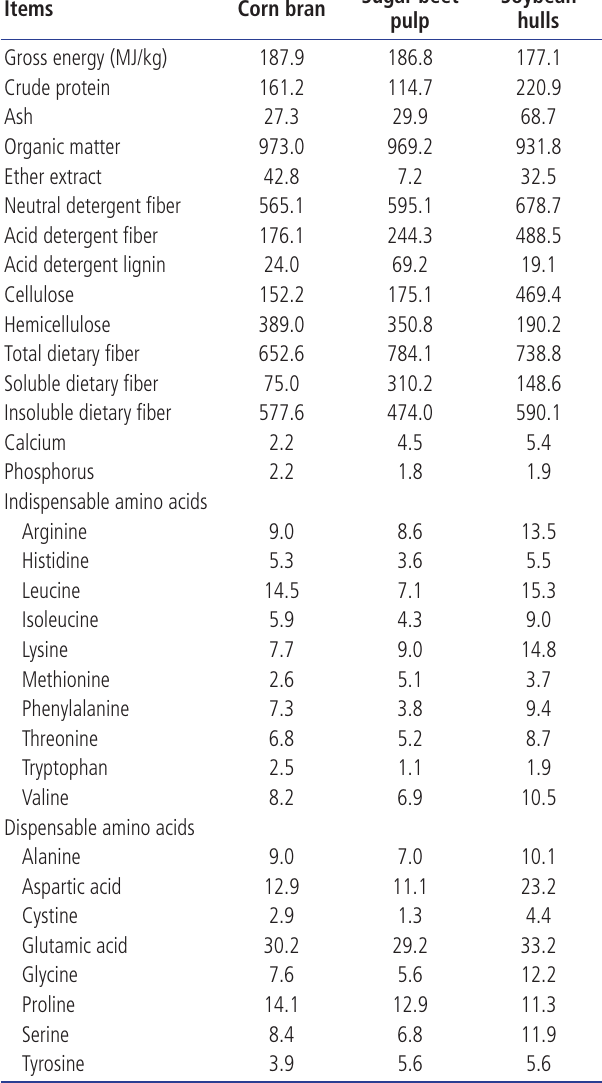
Table 1. The analyzed chemical compositions in corn bran, sugar beet pulp and soybean hulls (g/kg, dry matter basis) 1)